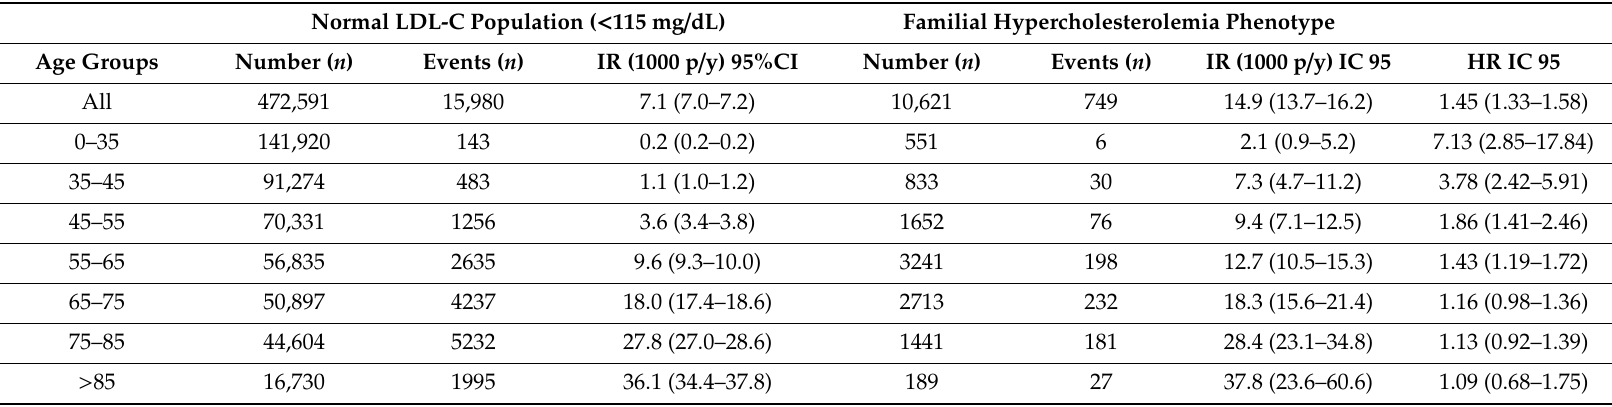
Table 2. Incidence rate (1000 person-years) and hazard ratio of atherosclerotic cardiovascular disease by age in primary prevention.